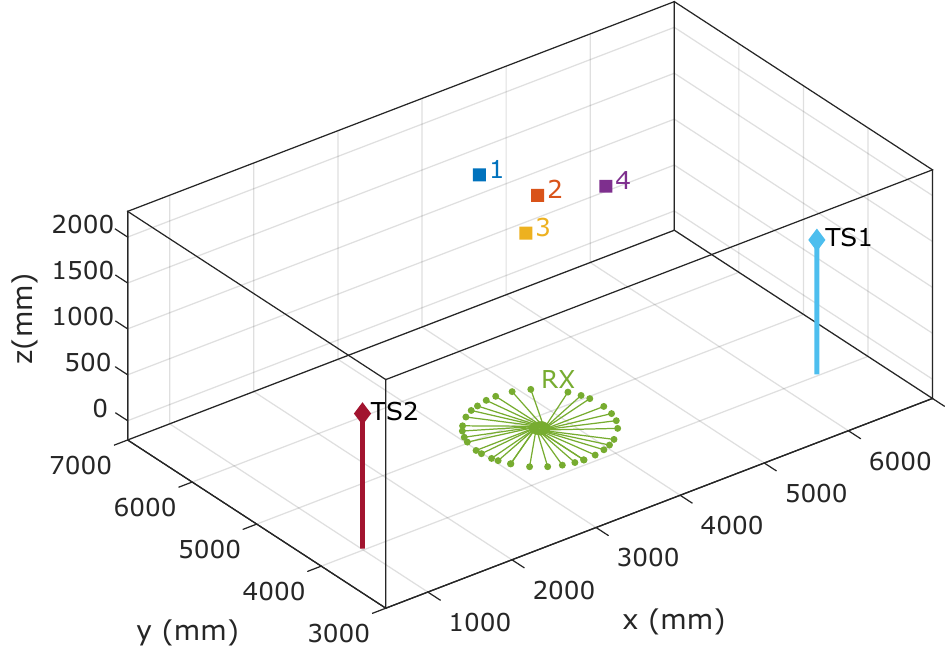
Figure 8. Emitter positions (1–4), receiver (green), and two total stations TS1/TS2 in the